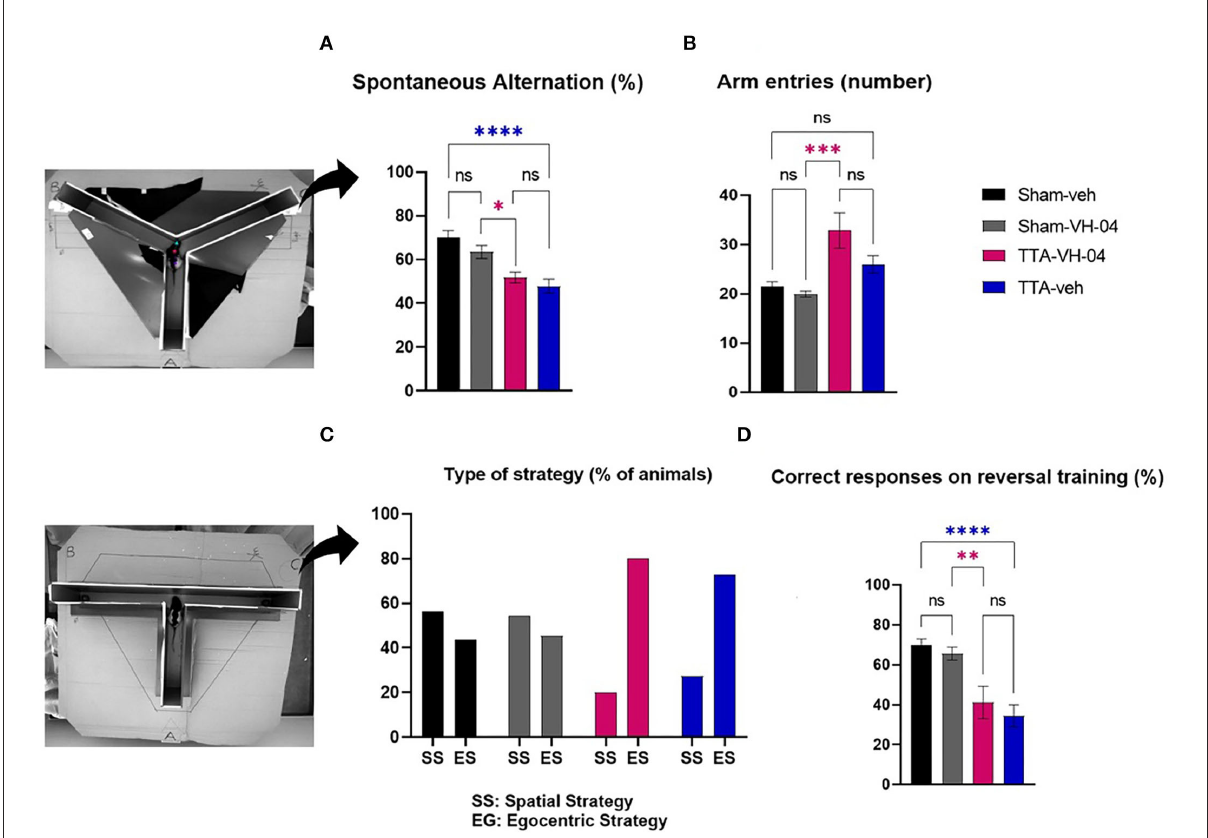
FIGURE5 Effect of Vertigoheel on immediate spatial working memory assessed by Y-maze (A,B) and on spatial cognitive strategy assessed by T-maze. (A) Spontaneous alternation percentage. (B) Number of arm entries. (C) Type of strategy percentage. (D) Percentage of correct responses on reversal training session. Data represent mean ± SEM. One-way ANOVA applies to all graphs except (C) . Significant differences between Sham-VH-04 and TTA-VH-04, and Sham-veh and TTA-veh are indicated by purple and blue stars, respectively. * p < 0.05; ** p < 0.01; *** p < 0.001; **** p < 0.0001. Sham-veh and Sham VH-04, n = 16; TTA-veh and TTA-VH-04, n =